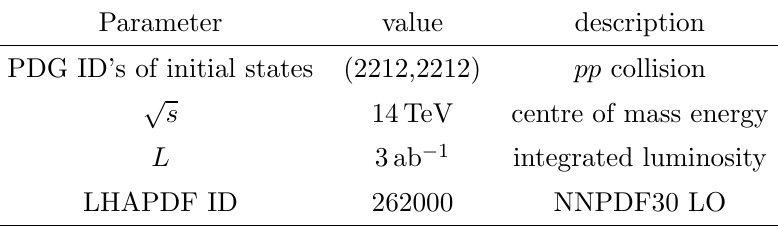
Table 7 . The collider parameters used in this work for the HL-LHC.